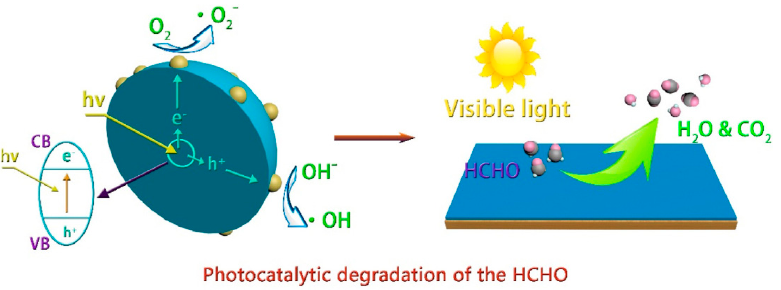
Figure 7. Schematic illustration of photocatalytic degradation of HCHO to CO 2 and H 2 O by wood covered with Fe-doped WO 3 [67].